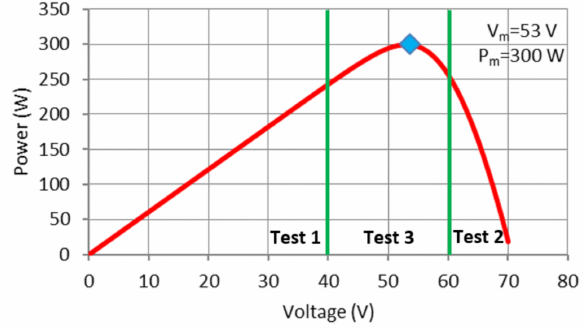
Figure 8. PV Characteristic for uniform irradiance